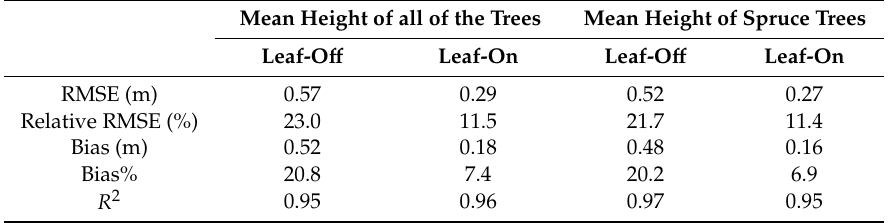
Table 8. Evaluation of the total and spruce mean tree heights among all sample plots ( n = 15). Mean Height of all of the Trees